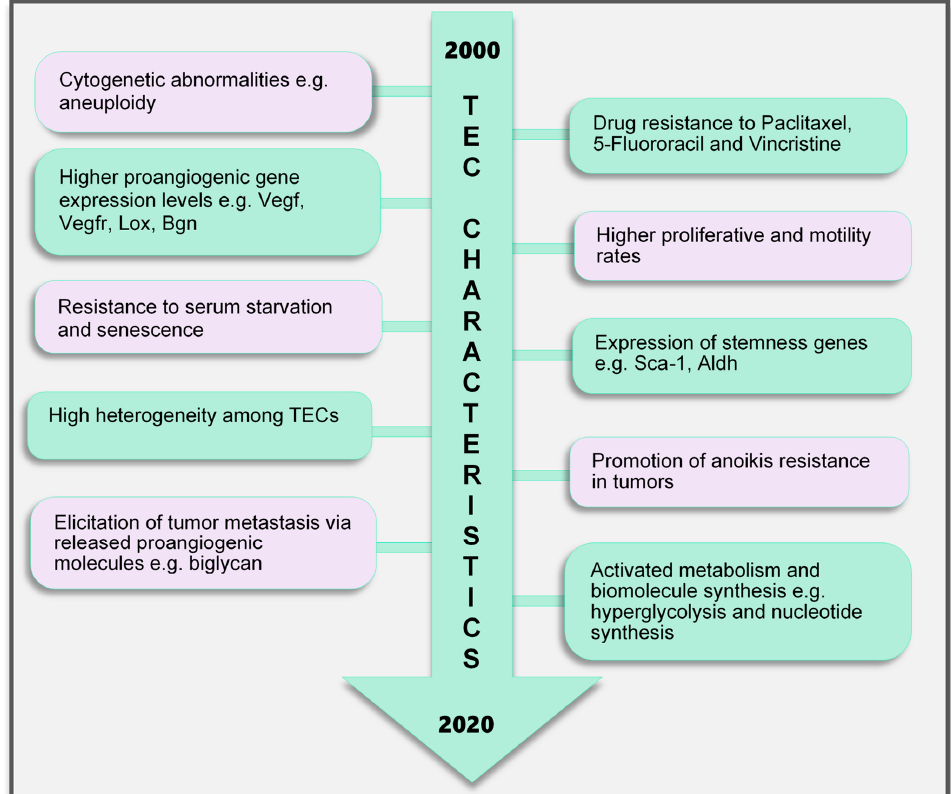
Figure 2. TEC characteristics identified to date. Various characteristics of TECs have been observed, which make them unique when compared with endothelial cells in normal blood vessels. These range from the genetic composition and expression of genes, abnormal karyotype, higher biological activities (proliferation and motility), and TEC influence on tumor cells to modulate cancer cell metastasis and survival to modifications in their metabolic signature. TECs are not normal and their abnormality creates a targetable avenue to influence the growth of tumors and improve therapeutics in cancer treatment. TEC, tumor endothelial